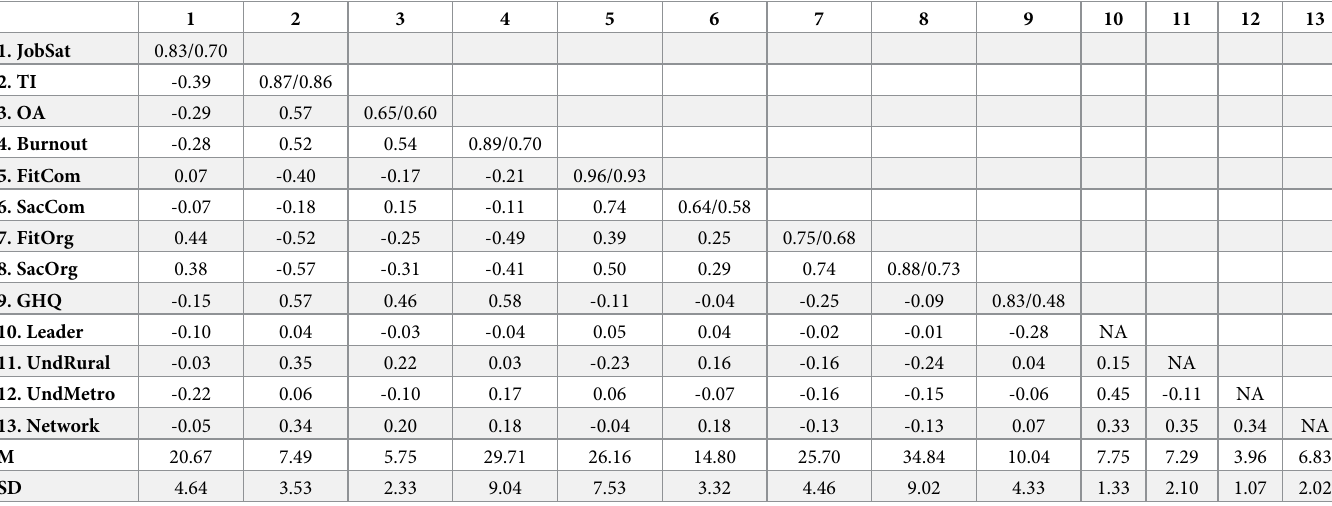
Table 2. Correlations, reliability, and central tendency coefficients for measured variables (n =